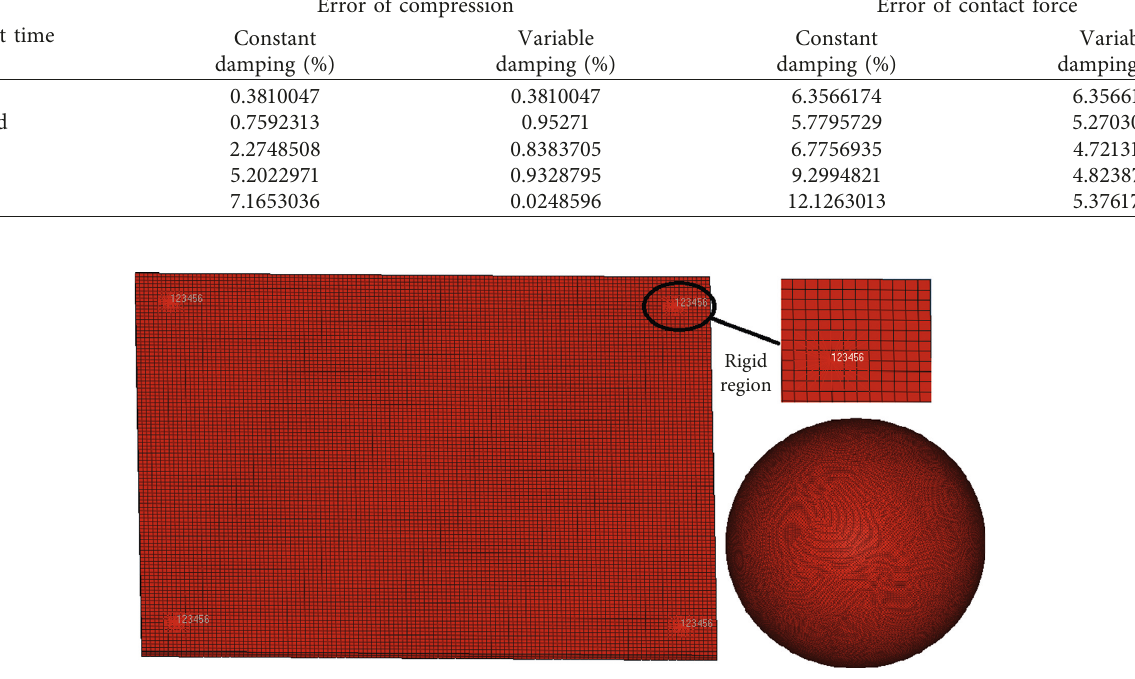
Figure 9: Component